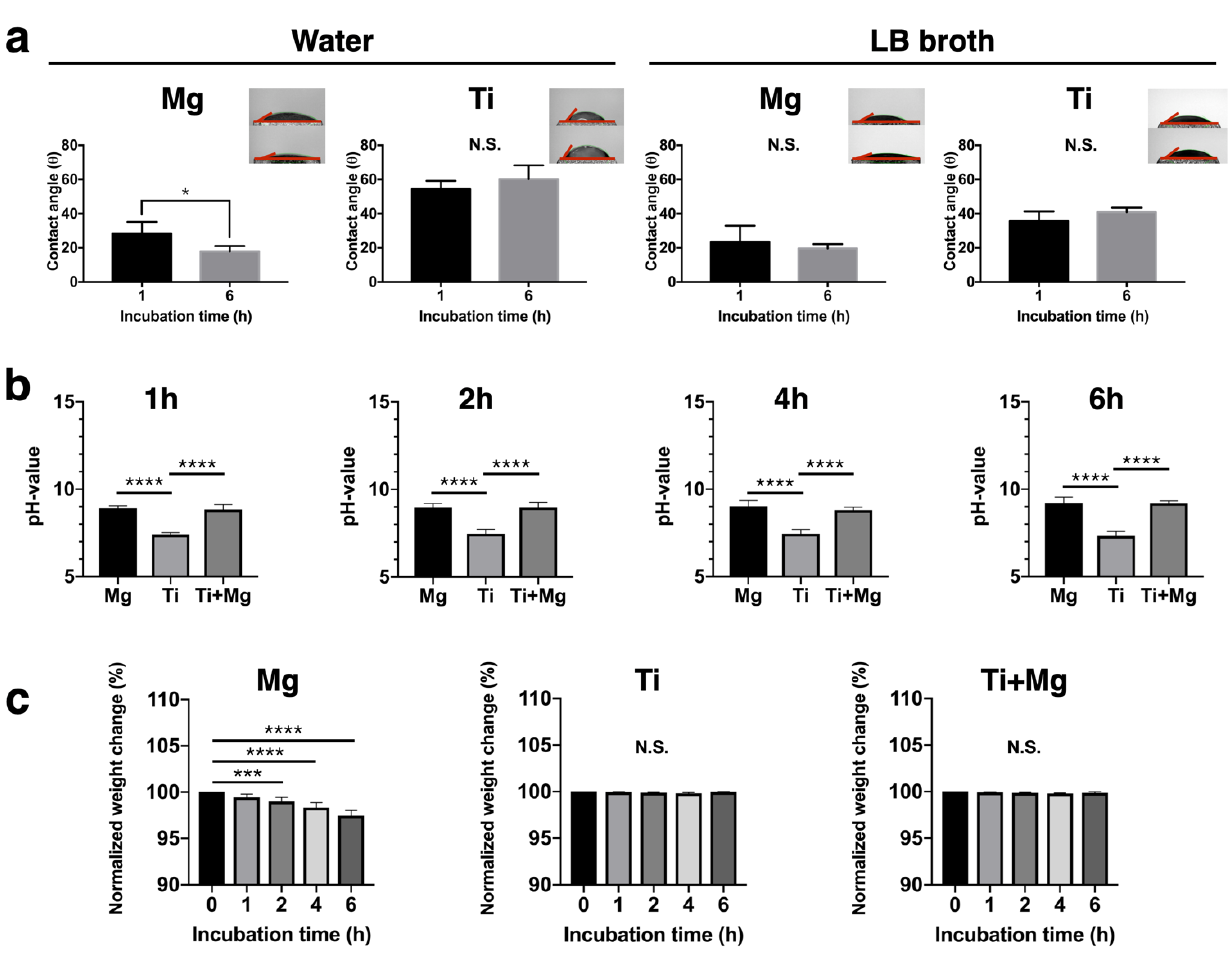
Figure 3. Surface wettability and degradation behavior of Mg and Ti materials. ( a ) Surface wettability of Mg and Ti after 1 and 6 h of incubation in water and LB broth, respectively. ( b ) pH values of the LB broth, with respect to Mg, Ti, and Ti +Mg groups after different incubation periods, and ( c ) weight change of materials at different periods after incubation ( n = 5 per group; N.S. no significant difference, * p < 0.05, *** p < 0.005, and **** p < 0.001). Table 2. The surface composition of Mg and Ti substrates ( n = 5 per